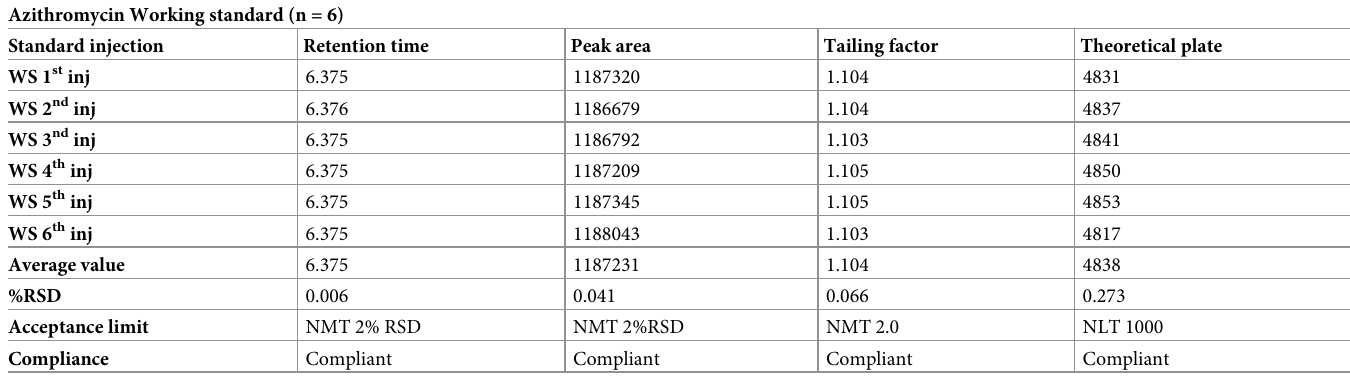
Table 6. System suitability test results for chromatographic method for Assay test.